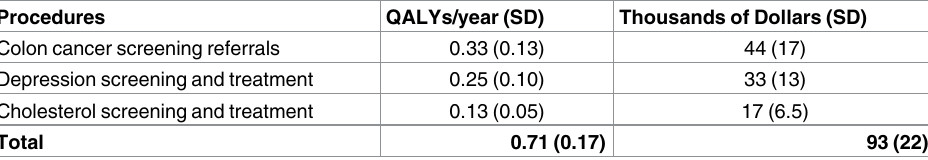
Table 4. Annual health and economic impact of potential preventive health interventions at UCC.